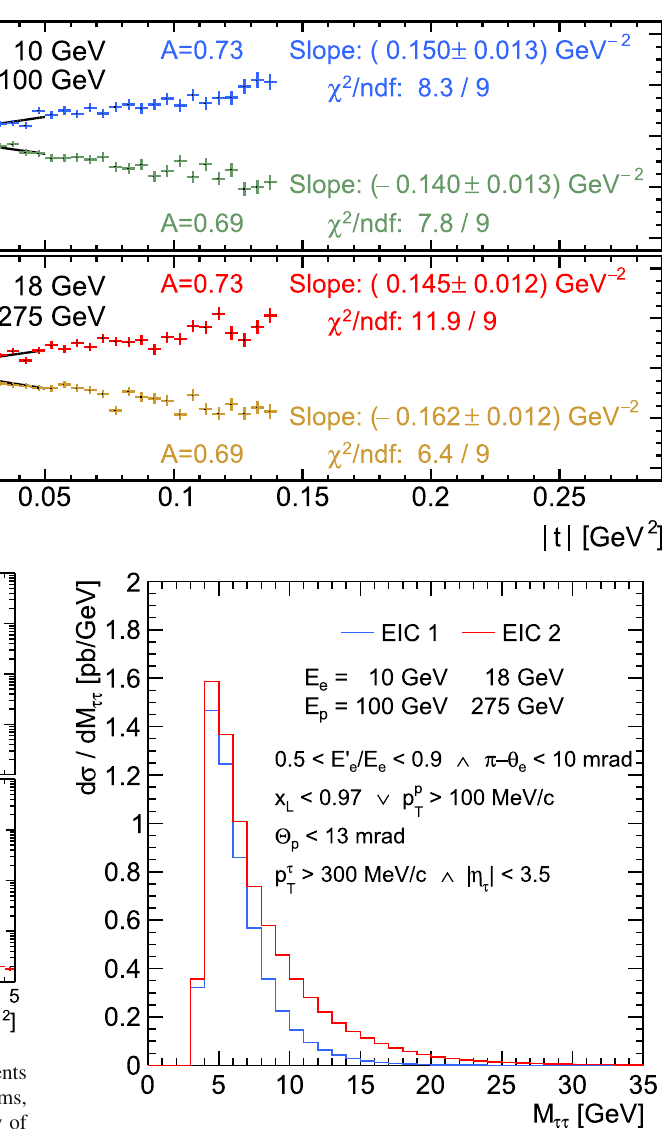
Fig. 6 The differential cross-section in the invariant mass M ττ of selected events according to “acceptance cuts” (see Sect. 2, without photon veto) for electron proton collisions at high (red histogram) and low (blue histogram) beam